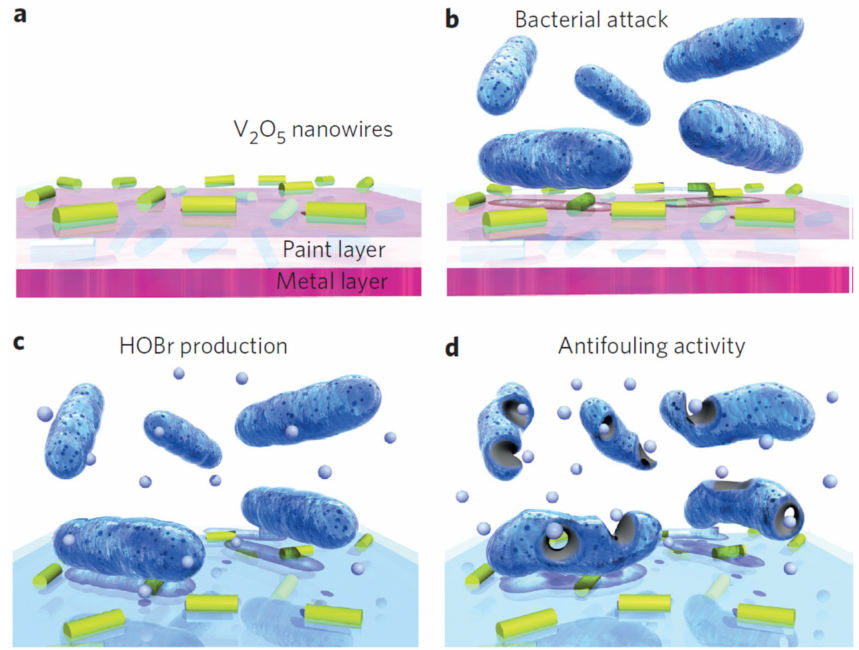
Figure 3. Bactericidal properties of V 2 O 5 nanowires mixed with antifouling paint proposed by Natalio et al. (Reproduced from [84], published by Springer Nature, 2012.). ( a ) Nanoparticles